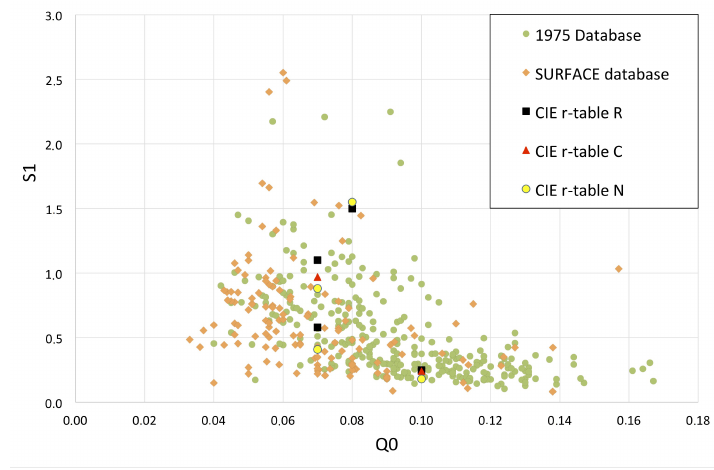
Figure 2. Q 0 and S 1 values of the original 1975 database, CIE road surface reference r -tables and the current SURFACE database composed of 138 stabilised